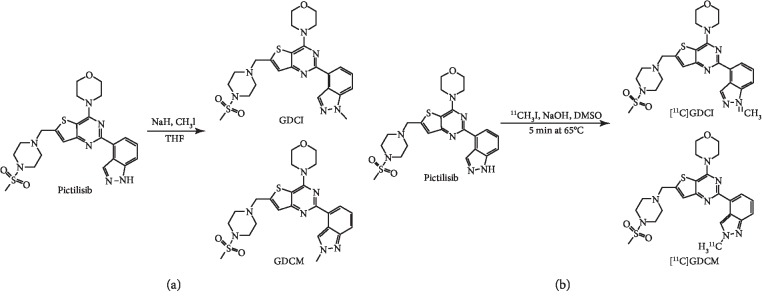
(a) Synthesis of reference standard methyl-pictilisib. (b) Diagram of [11C]-pictilisib one-step radiosynthesis.